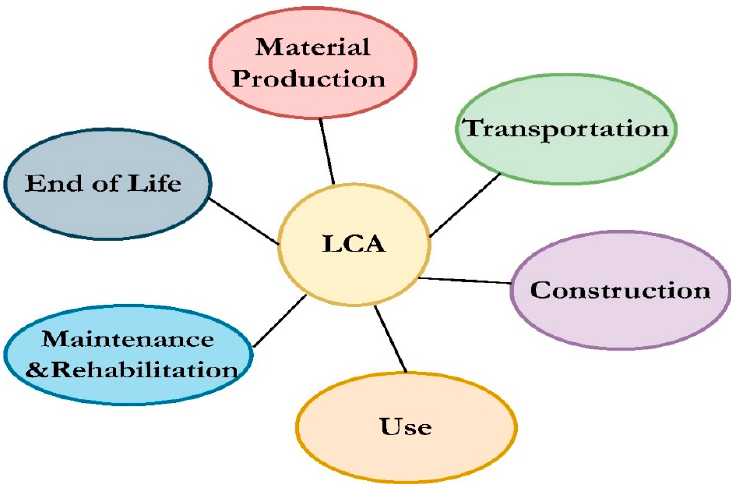
Figure 4. The LCA stages for asphalt pavement.